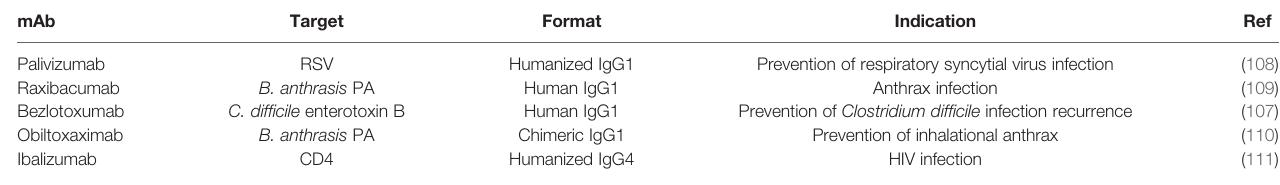
TABLE 2 | MAbs approved by the US FDA for treatment of infectious diseases. mAb